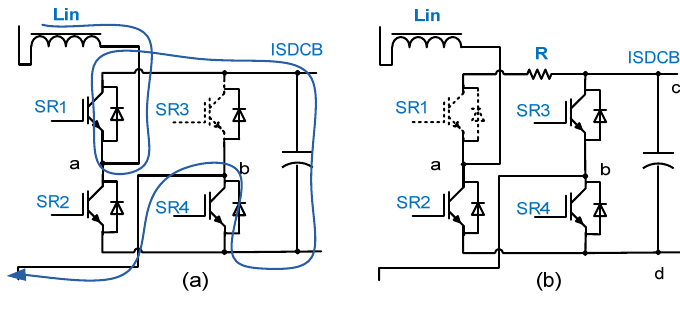
Figure 6. Schematic diagrams of input stage for ( a ) Fault A1 (IGBT SR3 open-circuit) and ( b ) Fault A2 (IGBT SR1 and its body diode